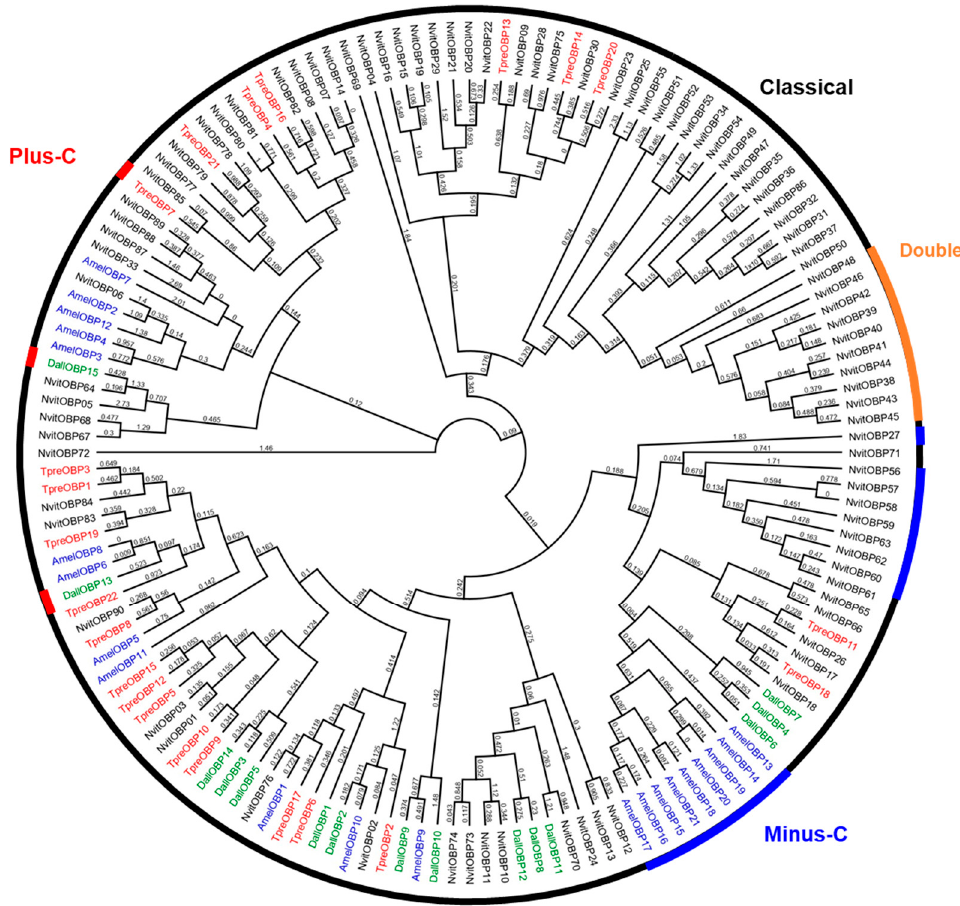
Figure 3. Phylogenetic analysis of OBPs from T. pretiosum (TpreOBPs), A. mellifera (AmelOBPs), N. vitripennis (NvitOBPs) and D. alloeum (DallOBPs). 22 TpreOBPs are marked in red, 21 AmelOBPs are marked in blue, 90 NvitOBPs are marked in black, and 15 DallOBPs are marked in green. Consensus support values are labelled on